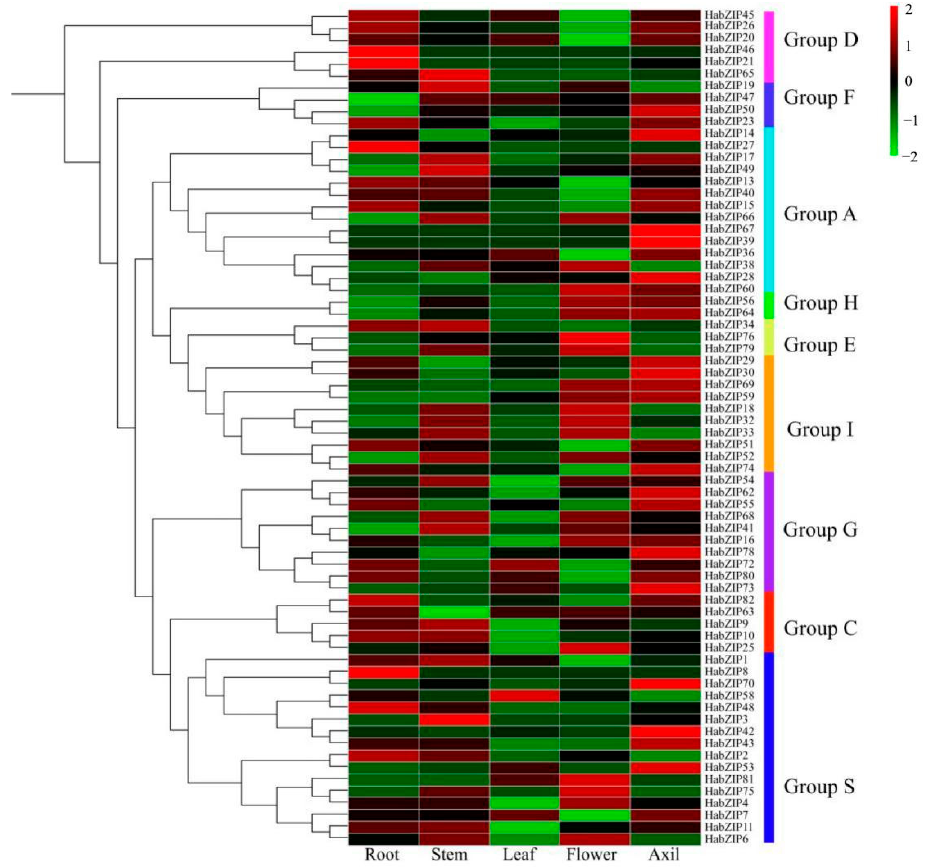
Figure 6. HabZIP gene expression analysis in five sunflower tissues. The transcript abundance of HabZIP genes is represented by the color scale ( − 2 to 2) and the latter’s heat map is the same as this.